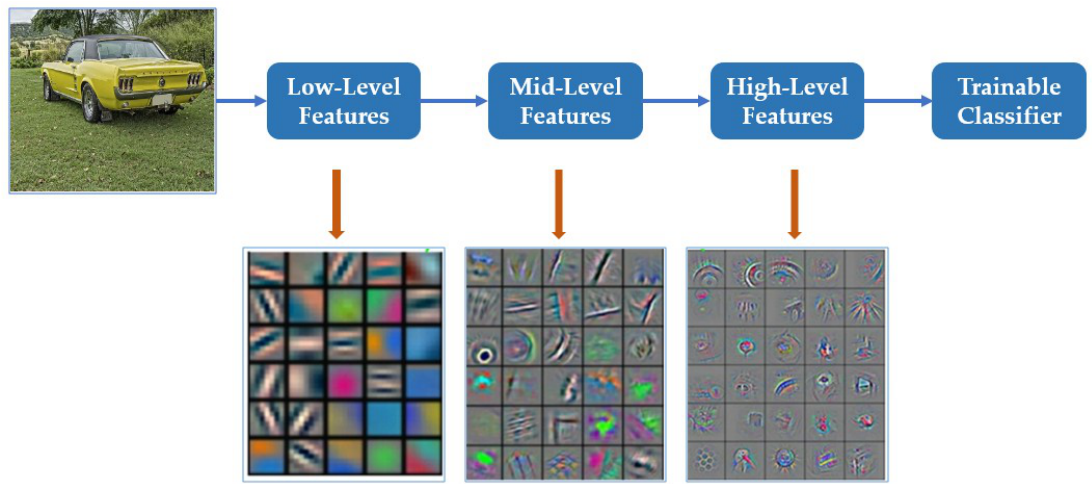
Figure 1. Convolutional kernels of each level by visualizing a pretrained convolutional neural network (CNN) model.